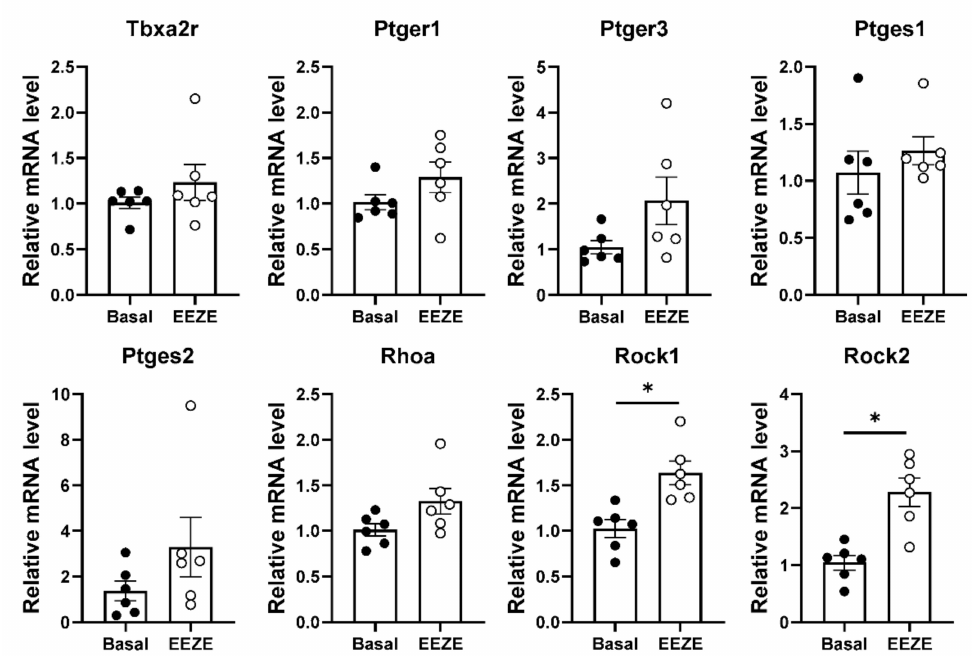
Figure 7. RT-qPCR for selected genes from aortic tissue pre-incubated with or without 14,15-EE-8(Z)-E. * p < 0.05, Mann–Whitney test. n = 6